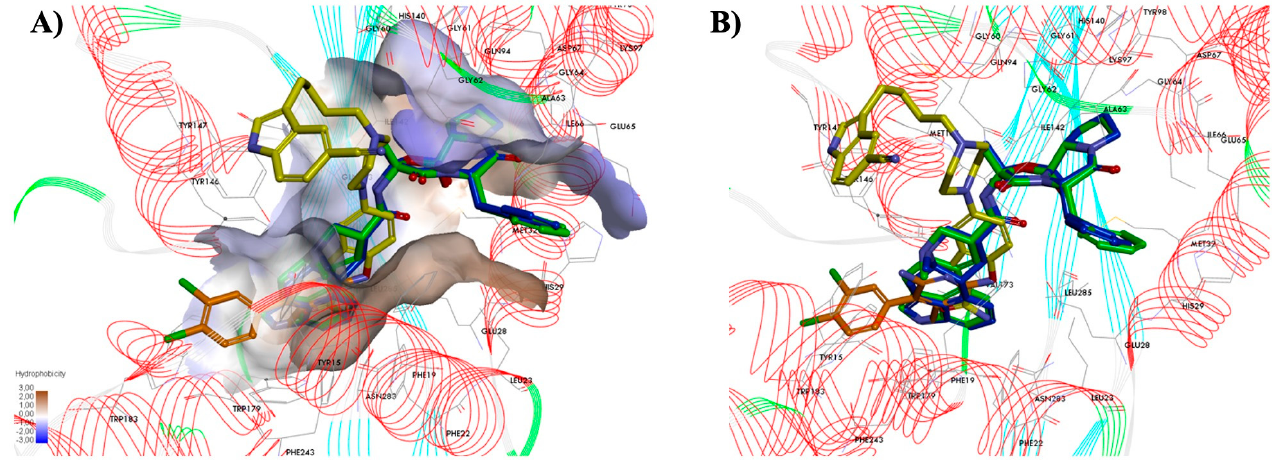
Figure 2. Binding mode of selected compounds with HNMT obtained by flexible docking studies employing CDOCKER. ( A ) The hydrophobic and hydrophilic amino acid residues surrounding the ligands. Surface hydrophobicity was depicted by the shaded colors: brown—the hydrophobic and blue—the lipophilic regions. ( B ) Superposition of compounds: metoprine (orange), dihydroergota- mine (blue), vilazodone (yellow), and ergotamine (green) in the histamine-binding site of HNMT.